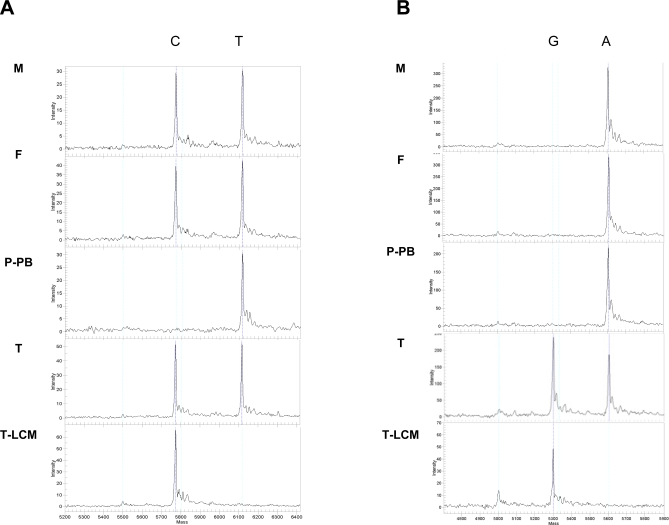
Analysis of the ATM C103T Mutation and the VKORC1 G9041A (rs7294) Polymorphism Showing Foreign Origin of the Tumor Cells(A) MALDI-TOF mass spectrometry of nucleotide 103 of the ATM gene using the SEQUENOM MassArray. C, wild type allele; T, the North African Jewish ATM mutated allele. F, father's PB; M, mother's PB; P-PB, patient's PB; T, tumor; T-LCM, isolated tumor cells obtained by LCM.(B) MALDI-TOF mass spectrometry of VKORC1 9041G/A (rs7294) polymorphism using the SEQUENOM MassArray. G/A, SNP at position 9041 (rs7294) of the VKORC1 gene. F, father's PB; M, mother's PB; P-PB, patient's PB; T, undissected tumor; T-LCM, isolated tumor cells obtained by LCM.